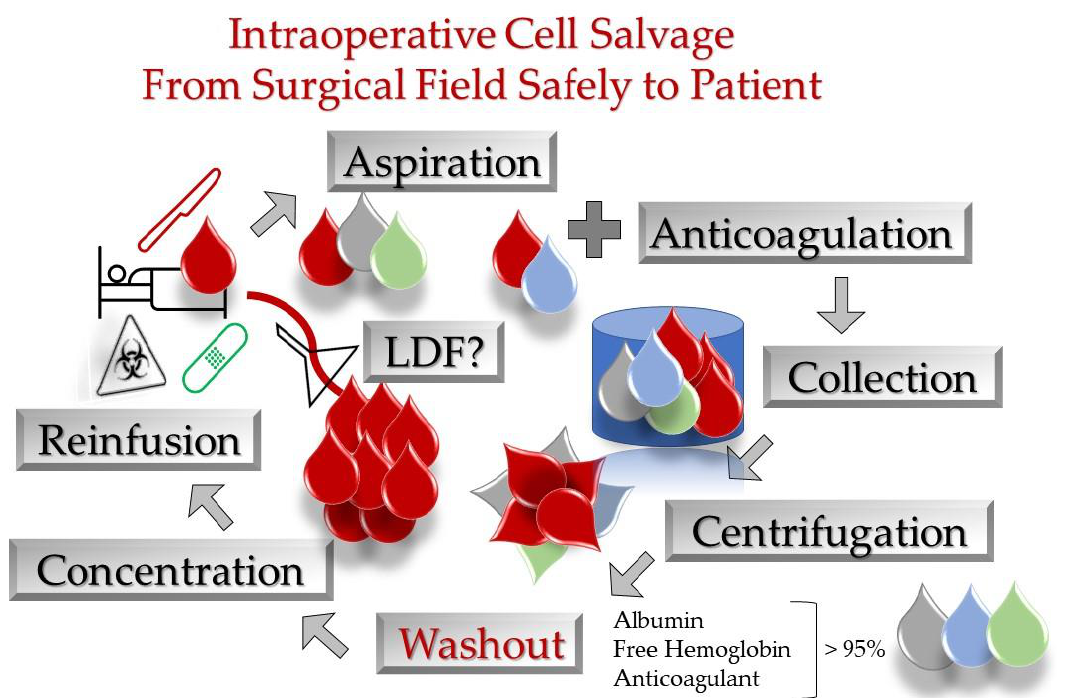
Figure 1. Conceptual workflow of intraoperative cell salvage (ICS). LDF: leukocyte depletion filters.